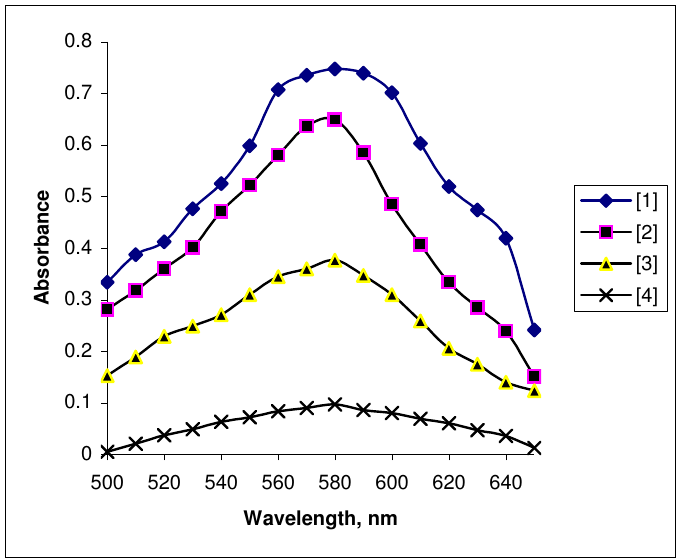
Figure 1 . Absorption spectra of the Se(IV) – iodine -starch complex with ascorbic acid (1) Blank (without AA) (2) 1.0 µg mL -1 (3) 4.0 µg mL -1 (4) 7.0 µg mL -1 measured against